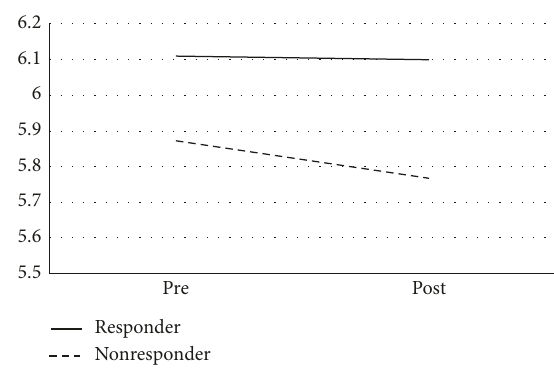
Figure 4: Changes in total gray matter volume. The figure shows changes in total gray matter volume (mm 3 plement group “responders” and “nonresponders.”